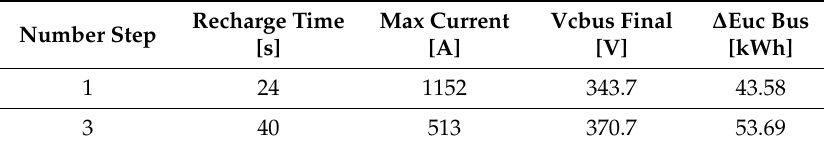
Figure 5. Voltages and currents as a function of time: ( a ) station side, ( b ) onboard side. Table 3. Comparison of 1 and 3 step recharge.